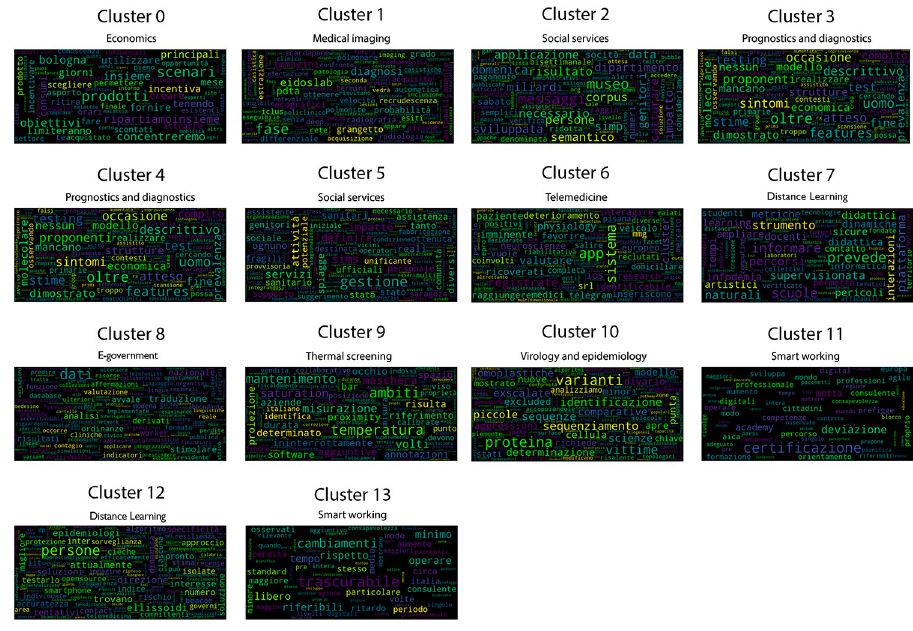
Fig 32. Tag-cloud of clusters for